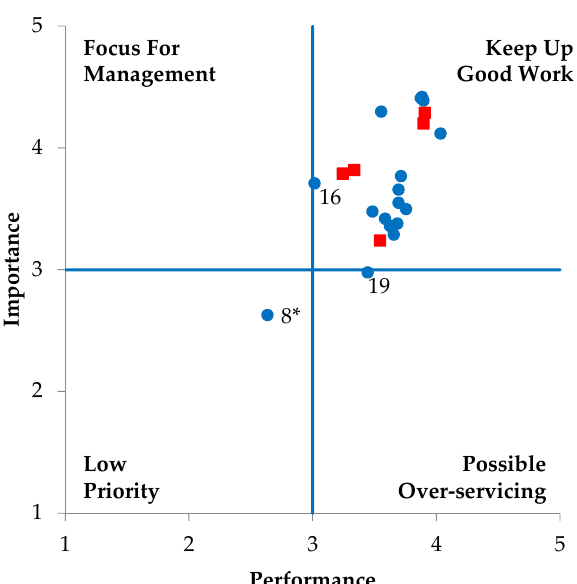
Figure 2. Scale-centered IPA. Attributes shown as a red square if there was not a significant correlation between the Importance and Performance ratings, which suggests possible differences in opinion between subgroups of PGI users regarding that attribute.